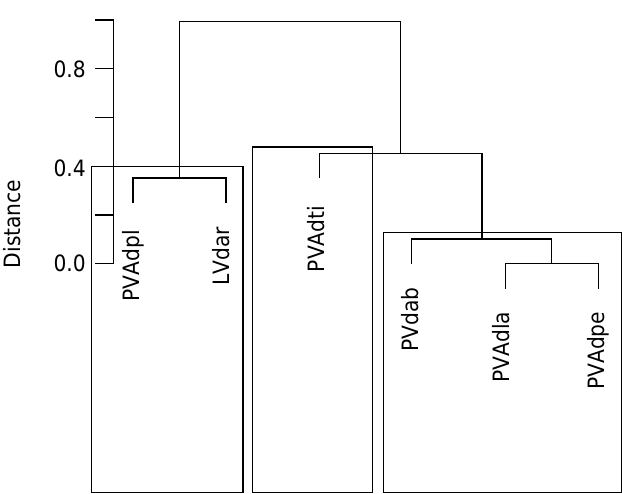
Figure 3. Dendrogram with the clustering of soil classes (profiles), in relation to fruit production and number of individuals. PVAdpl: Argissolo Vermelho-Amarelo Distrófico plintossólico ; LVdar: Latossolo Vermelho Distrófico argissólico ; PVAdti: Argissolo Vermelho-Amarelo Distrófico típico ; PVdab: Argissolo Vermelho Distrófico abrúptico ; PVAdla: Argissolo Vermelho-Amarelo Distrófico latossólico ; PVAdpe: Argissolo Vermelho-Amarelo Distrófico petroplíntico .